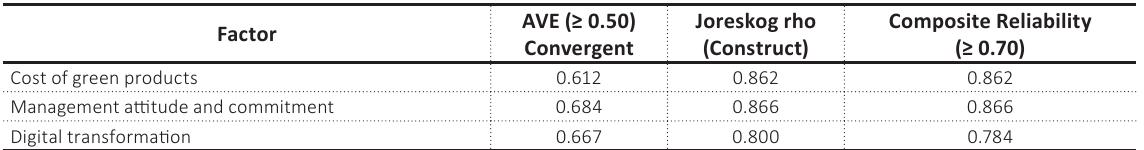
Figure 2. A model to measure and manage green initiatives at public universities Table 4. Validity and composite reliability